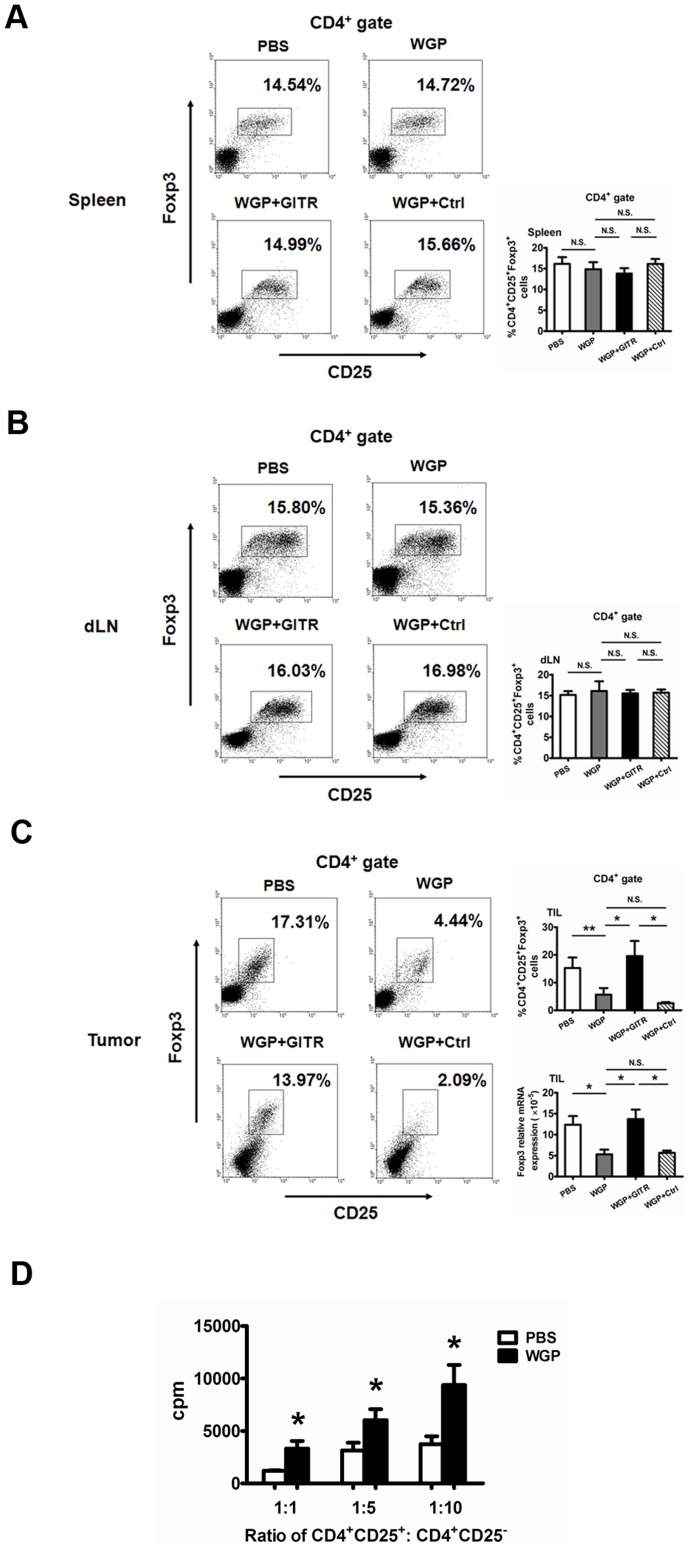
WGP alters the suppressive capacity of regulatory T cells in spleens.Groups of mice (n = 6) bearing established Lewis lung carcinoma were treated as described in Materials and Methods. (A, B, C) Single cell suspensions from spleens (A), draining lymph nodes (B) and tumor tissues (C) were stained with fluorochrome labeled mAbs to evaluate the proportions of CD4+CD25+Foxp3+ Tregs. Cells were gated on CD4+ T cells. RNAs from tumor specimens were extracted and Foxp3 mRNA expression was analyzed by qRT-PCR. (D) Splenic CD4+CD25+ Tregs isolated from tumor-bearing mice treated with or without WGP were co-cultured with CD4+CD25− Teffs from wild type C57BL/6 mice in the presence of anti-CD3 mAb and anti-CD28 mAb for 72 h. Wells were pulsed with 1 µCi/well [3H]-thymidine and analyzed as described in Materials and Methods. **P<0.01, *P<0.05, N.S. represents no significance between columns.